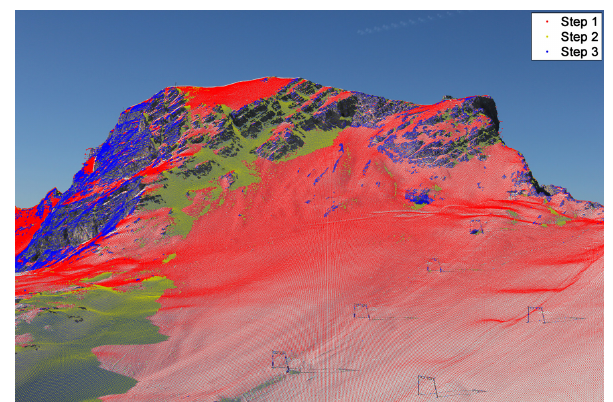
Figure 4. Stepwise classification of the SLR photograph on 17 November 2011 with the new PCA-based classification: in a first step, the algorithm of Salvatori et al. (2011) is used to classify sunlit snow (red). Then, shaded snow (yellow-green) is detected with the PCA classification, and in the third step, sunny rock (blue) is classi- fied comparing blue and red band DN. All unclassified pixels after these steps, mainly shaded rock, are subsequently classified using the blue band DN (not shown here, see Fig.